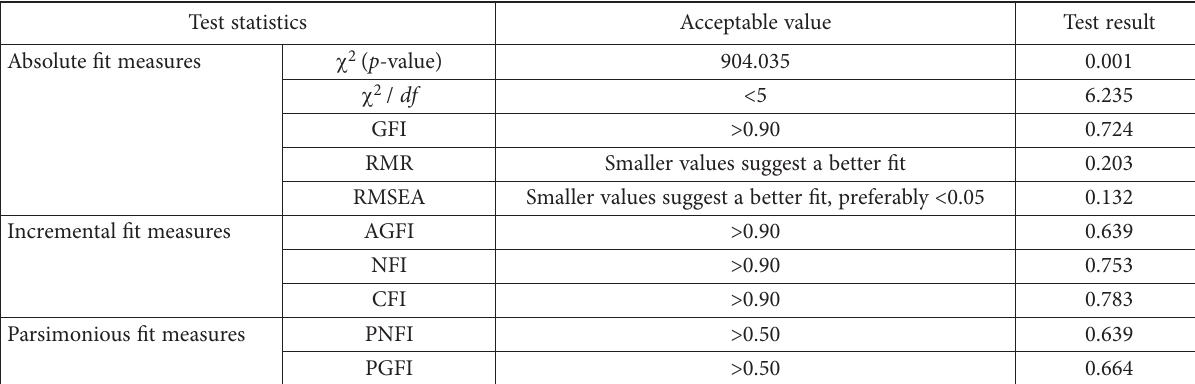
Table 5. Goodness-of-fit indices of the conceptual framework model developed in this study Test